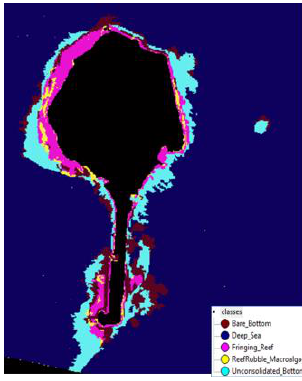
Figure 2. DubaiSat-2 classification map of Dalma Island